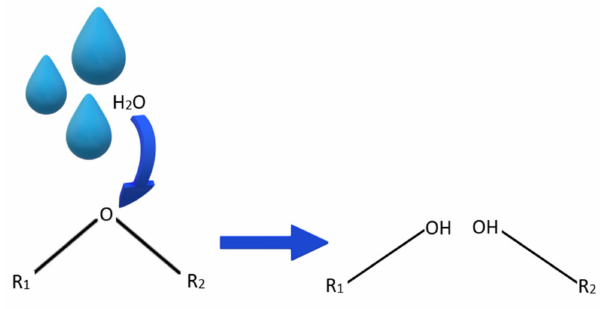
Figure 3. Ether hydrolysis